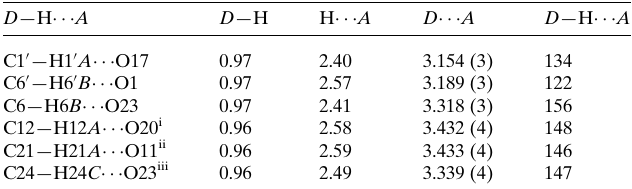
Table 1 Hydrogen-bond geometry (A˚ , (cid:5) ).